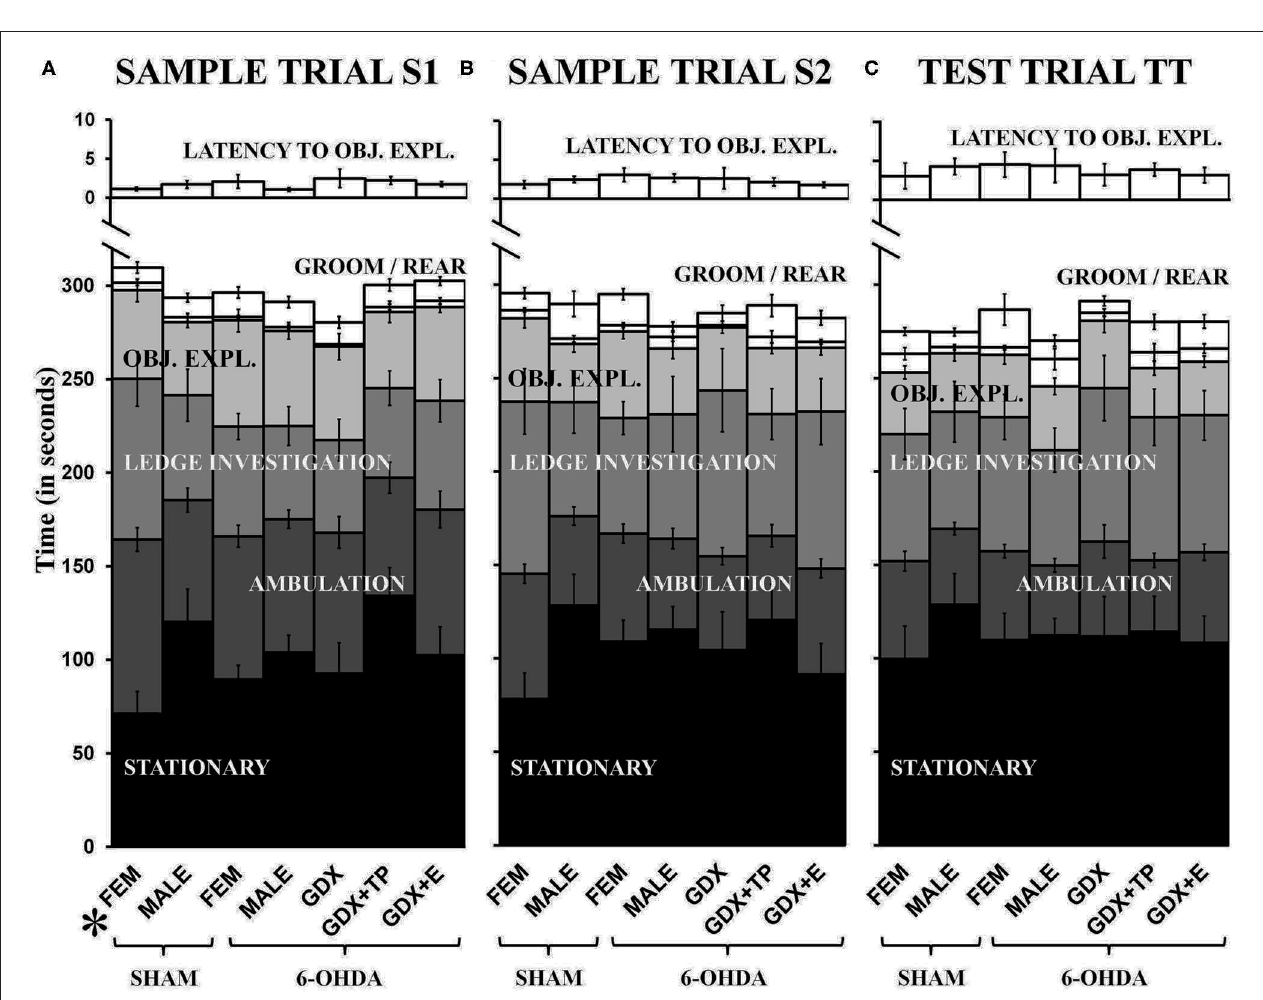
FIGURE 2 | caudate. Sections from a 6-hydroxydopamine (6-OHDA) lesioned female ( B , FEM 6-OHDA), a 6-OHDA lesioned male ( C , MALE 6-OHDA) and from 6-OHDA lesioned rats that were gonadectomized ( D , GDX 6-OHDA), GDX and supplemented with testosterone propionate ( E , GDX + TP 6-OHDA), or GDX and supplemented with 17 β -estradiol ( F , GDX + E 6-OHDA) all show discrete bilateral zones of diminished TH-immunostaining (outlined). The experimental timeline showing when lesions and sham lesion were made is shown above, and bar graphs (G) and bar graphs showing group average sizes and symmetries of 6-OHDA lesions, expressed as percentages of the left (LEFT), right (RIGHT), and total (TOTAL) caudate nucleus volumes ± standard error of the mean, are shown below for all groups below. cc, corpus callosum; NA, nucleus accumbens; SP, septal nucleus; lv, lateral ventricle; OT, olfactory tubercle. Scale bar in B = 1mm.